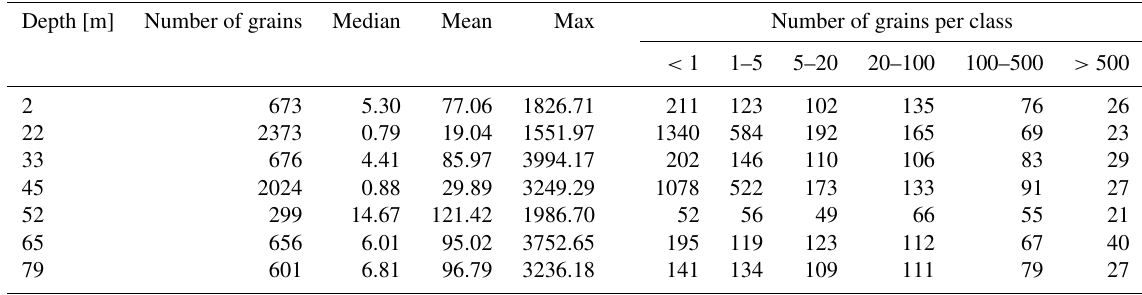
Table 3. Grain size distribution (median, mean and maximum grain sizes [mm 2 ]; minimum grain size is 0.2mm 2 and defined as the threshold during processing) and number of grains within defined grain size classes [mm 2